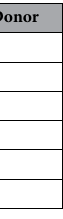
Table 1. Donor profiles for human split thickness skin